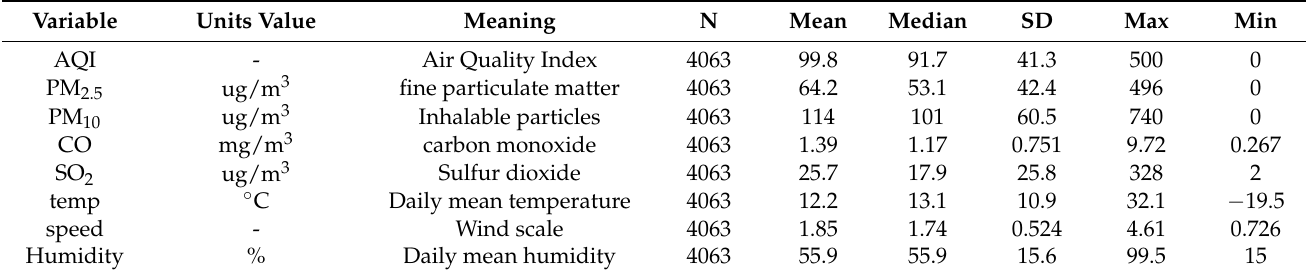
Table 1. Description of variables and data.